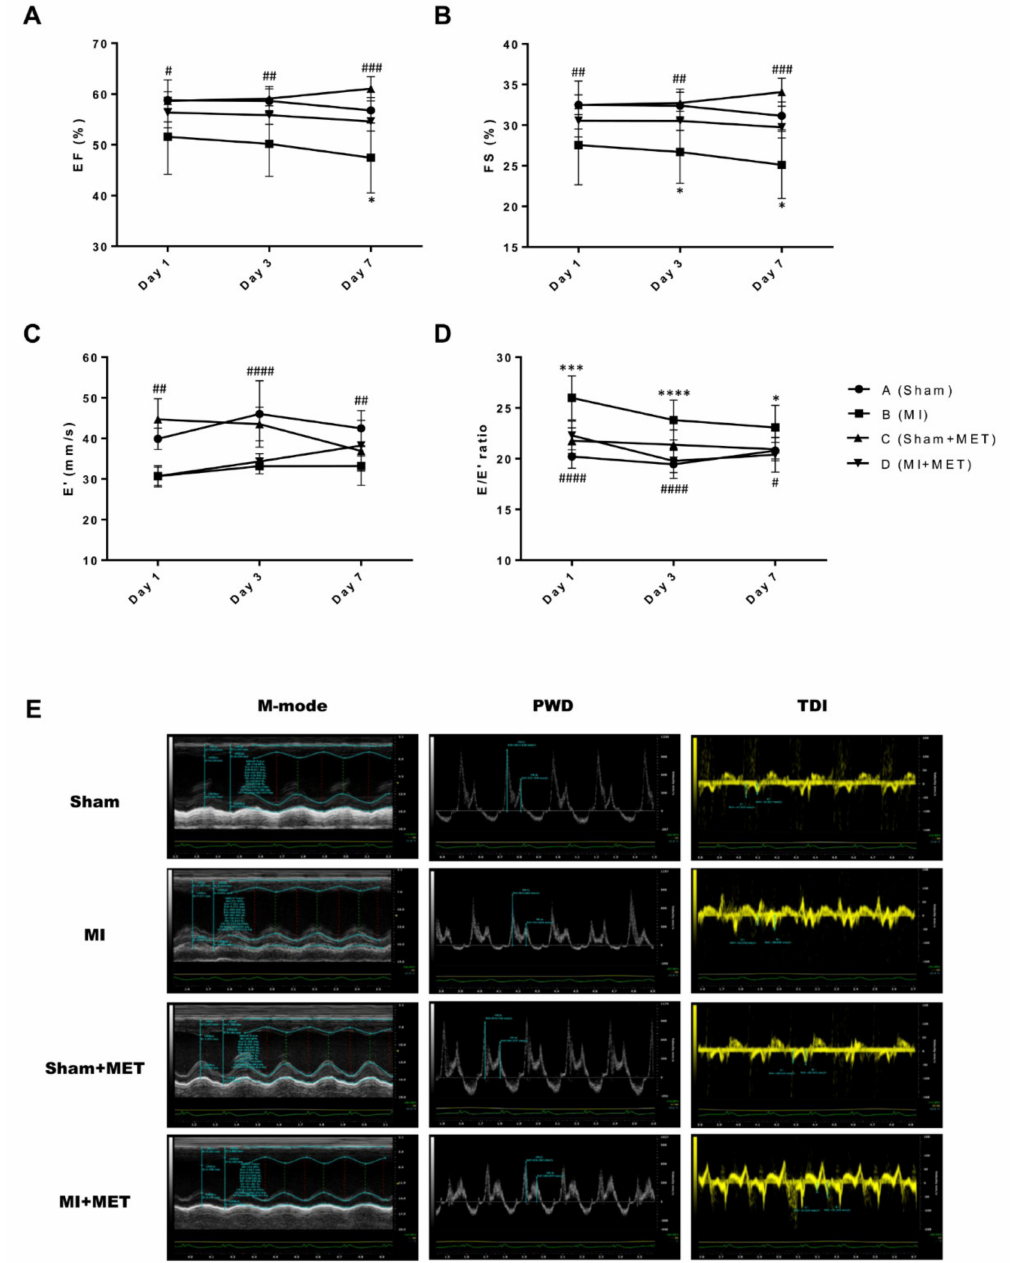
Figure 2. Echocardiographic results and representative echocardiographic imaging of rat hearts on Day 3 after MI surgery. Metformin administration significantly improved LV diastolic function. ( A ) Ejection fraction, EF; ( B ) Fractional shortening, FS; ( C ) Early relaxation velocity on tissue doppler, E’; ( D ) E / E’ ratio of diastolic function. EF and FS determined by M-mode imaging reflects LV systolic dysfunction; the E’ and E / E’ ratio determined by pulse wave doppler and tissue doppler imaging reflects LV diastolic dysfunction. ( E ) representative echocardiographic imaging. * p < 0.05, *** p < 0.001, **** p < 0.0001 between group B and D; # p < 0.05, ## p < 0.01, ### p < 0.001, #### p < 0.0001 between group A and D by Dunnett’s multiple comparisons test compared with MI group. PWD, Pulse Wave Doppler; TDI, Tissue Doppler